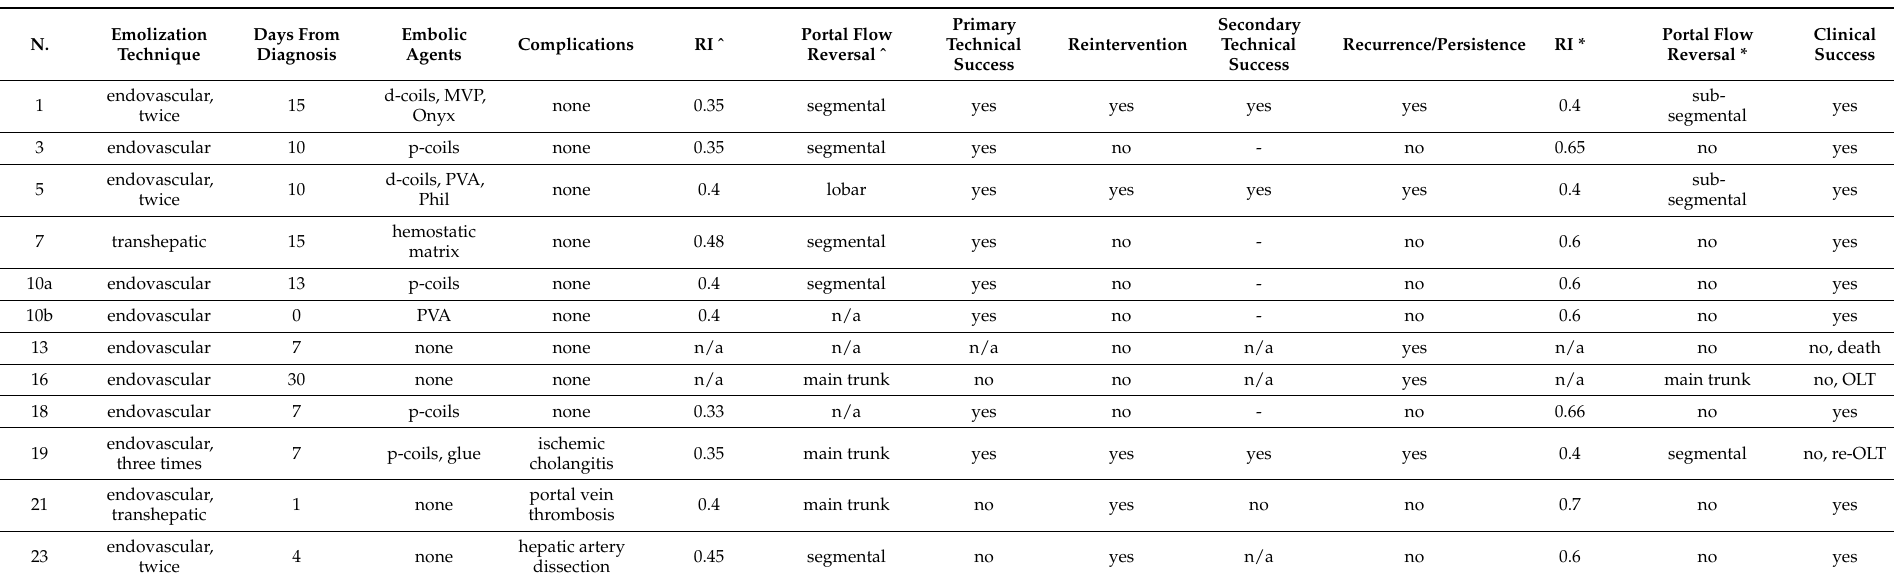
Table 2. Procedural details and outcomes of the interventional radiological management